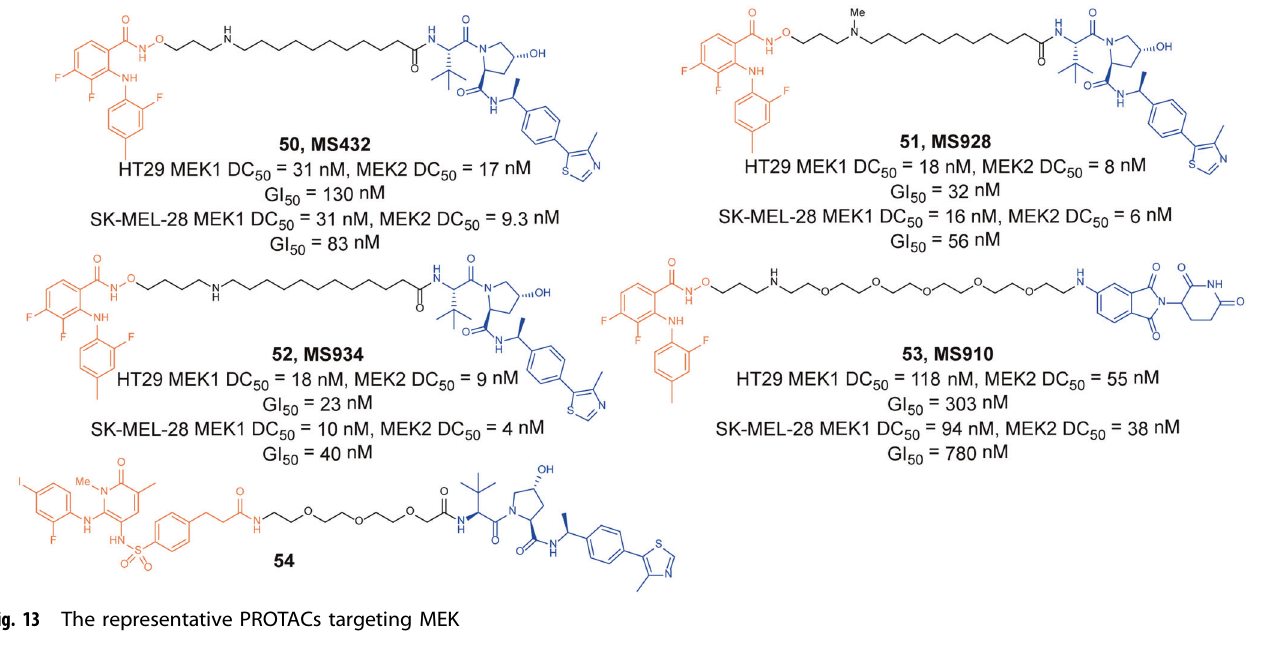
Fig. 13 The representative PROTACs targeting